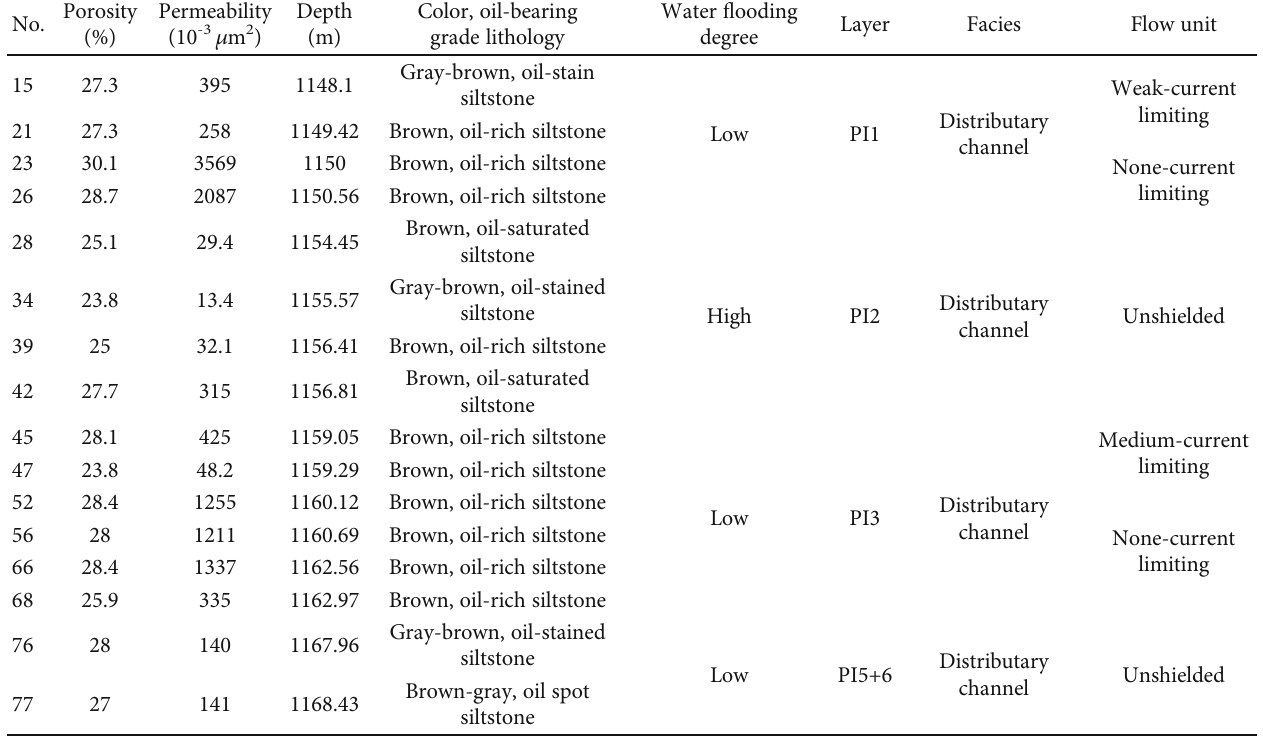
Table 8: Samples of freeze- fl uorescence thin section.